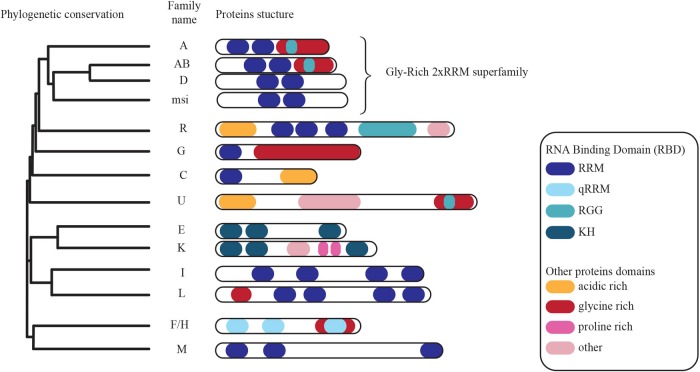
Phylogenetic conservation of members of the heterogeneous nuclear ribonucleoprotein family of proteins. Conserved functional domains are highlighted (modified from Geuens et al., 2016).